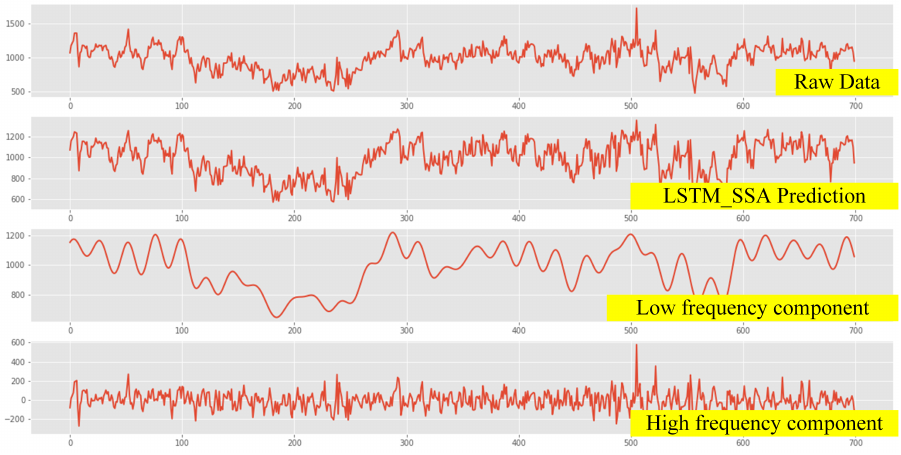
Figure 13. Intercepted Fragments of Simulation